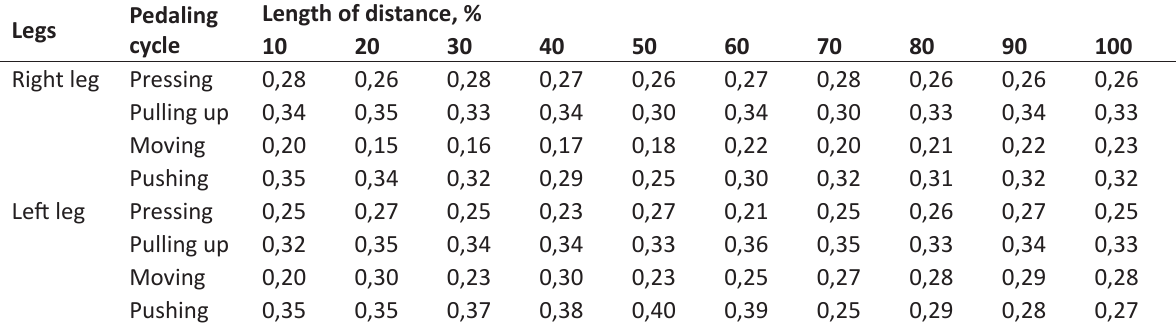
Table 2. Dynamic of time characteristics (moments of maximal forces) in pedaling cycle of elite cyclists on model pursuit racing, sec. Legs